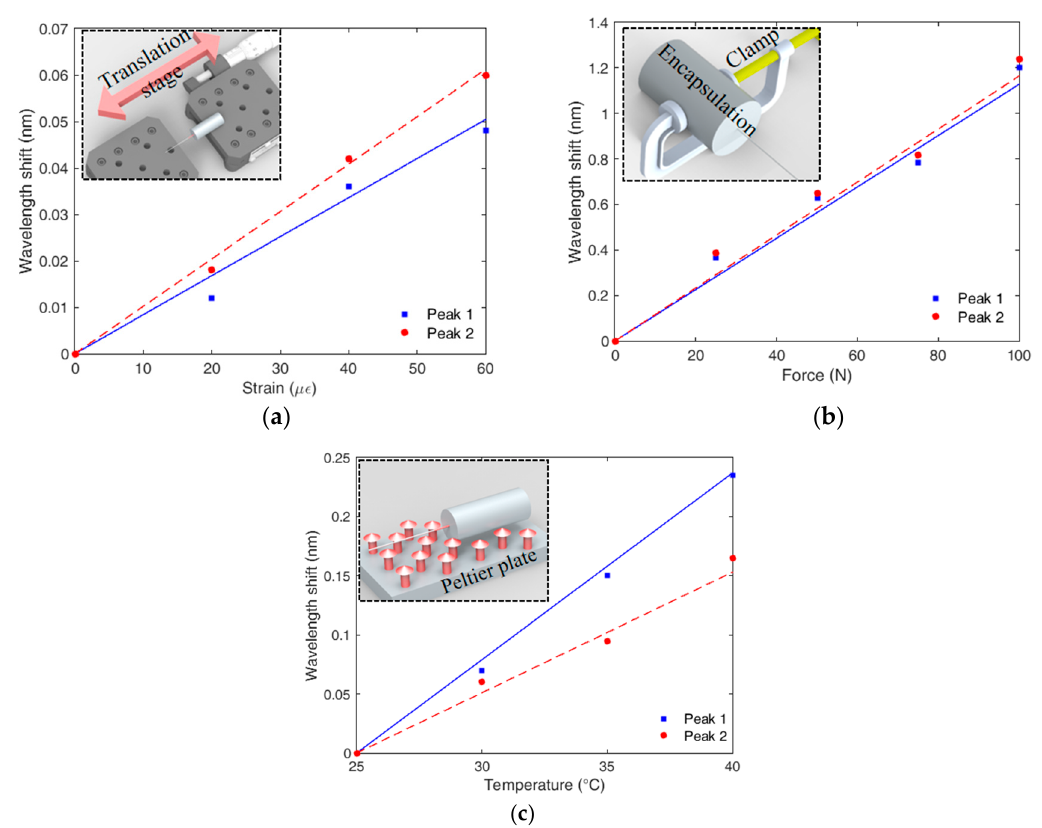
Figure 5. Wavelength shift for the half-embedded TPU structure in the tests of ( a ) strain, ( b ) transverse force and ( c ) temperature.